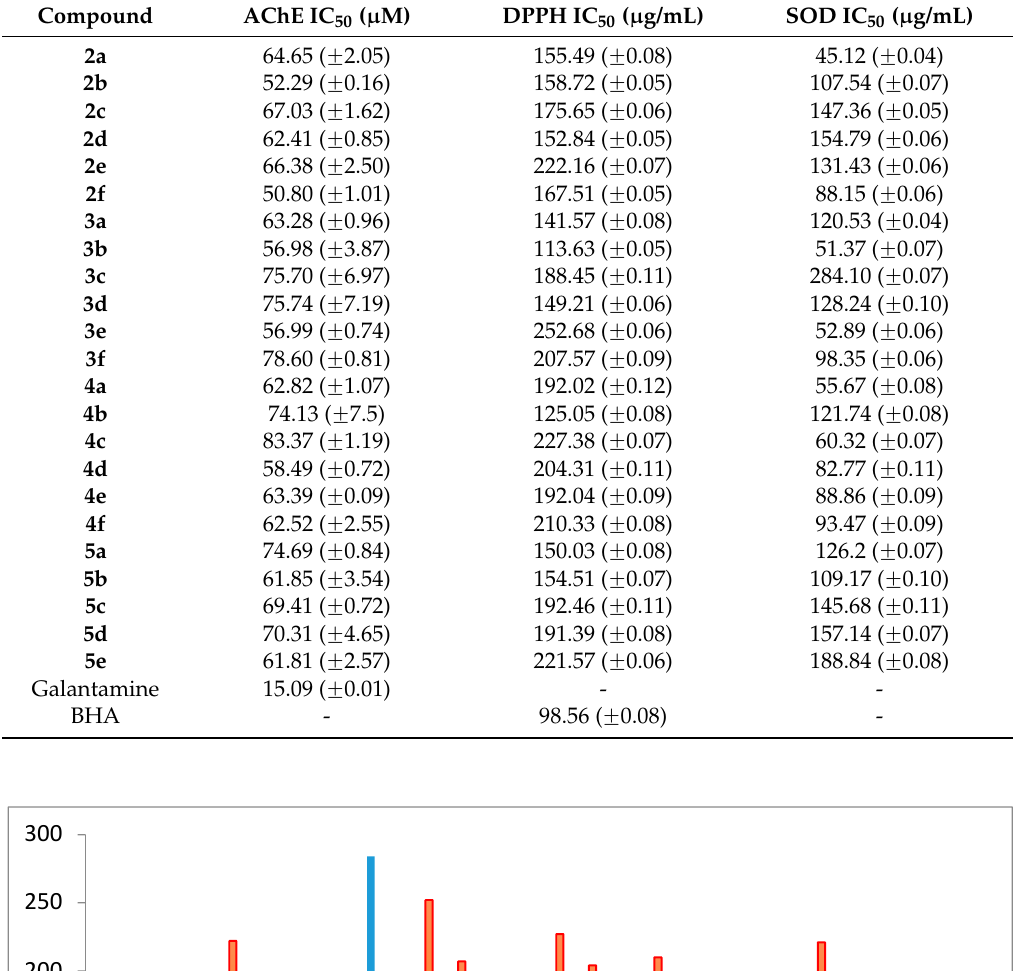
Table 1. IC 50 values of the 1,2,3-triazole compounds 2 – 5 ( a – f ) for AChE inhibition, DPPH and SOD activities.